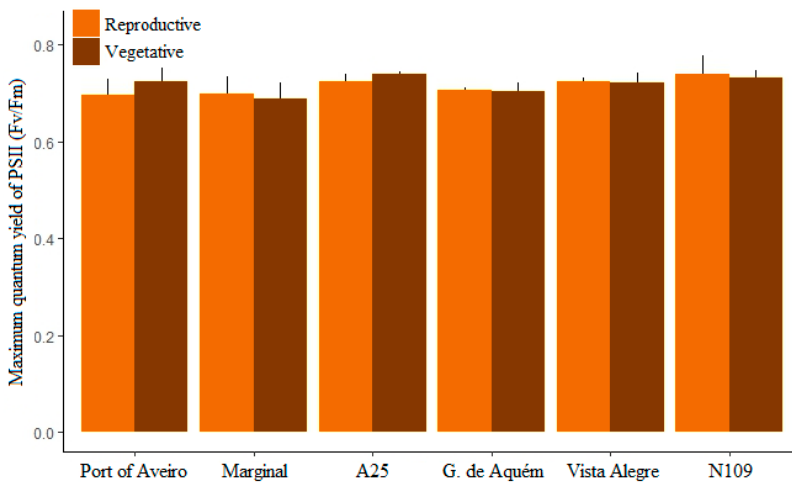
Figure 3. Maximum quantum yield of photosystem II (Fv/Fm) in vegetative and reproductive tissues of Fucus vesiculosus at the six locations from the inlet of Ria de Aveiro and along the Ílhavo Channel, Portugal. Mean + standard deviation; n = 5.